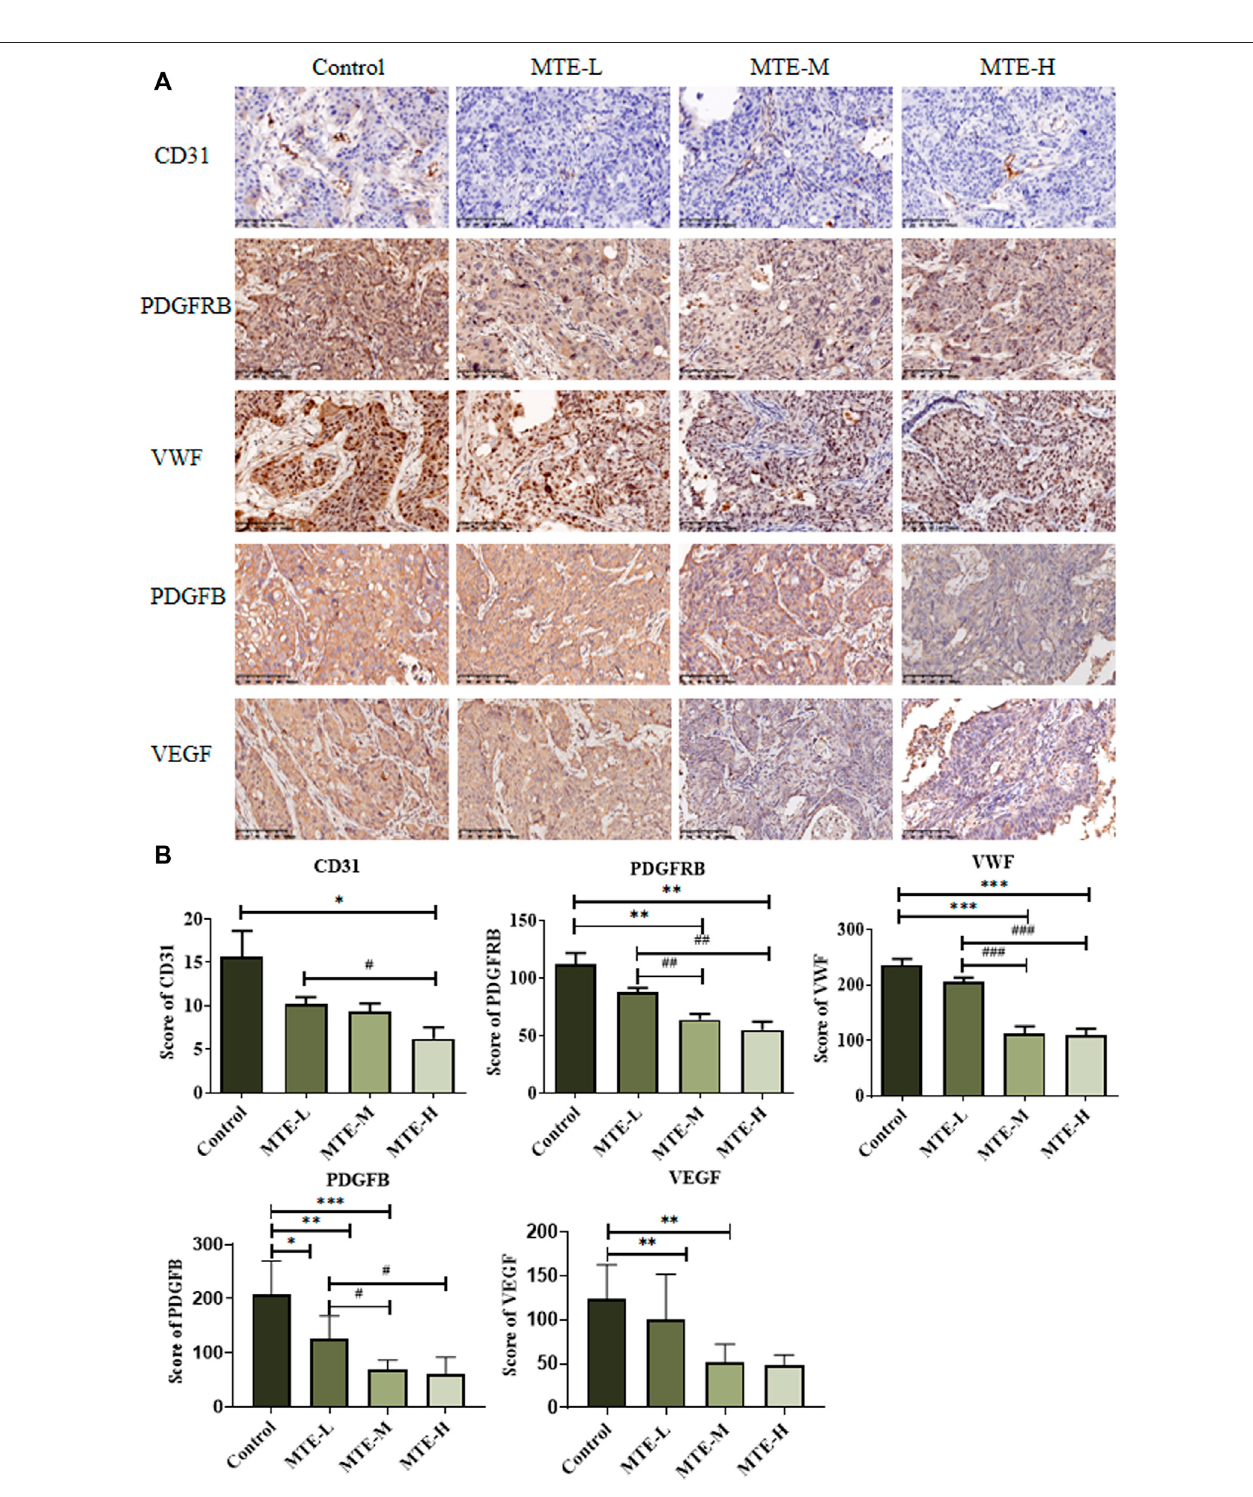
FIGURE 5 | MTE inhibited tumor angiogenesis in the HCC-PDX mouse model. (A) Representative images of IHC of angiogenesis-associated proteins (CD31, PDGFRB, VWF, PDGFB, and VEGF) on pathological slides of HCC-PDX tissues from control, MTE-L, MTE-M, and MTE-H groups. (B) Score of CD31, PDGFB, VEGF, PDGFRB, and VWF positive staining in these slides. Magni fi cation: ×200. Compared with control, * p < 0.05; ** p < 0.01; *** p < 0.001. Compared with MTE-L, # p < 0.05; ## p < 0.01; ### p < 0.001.